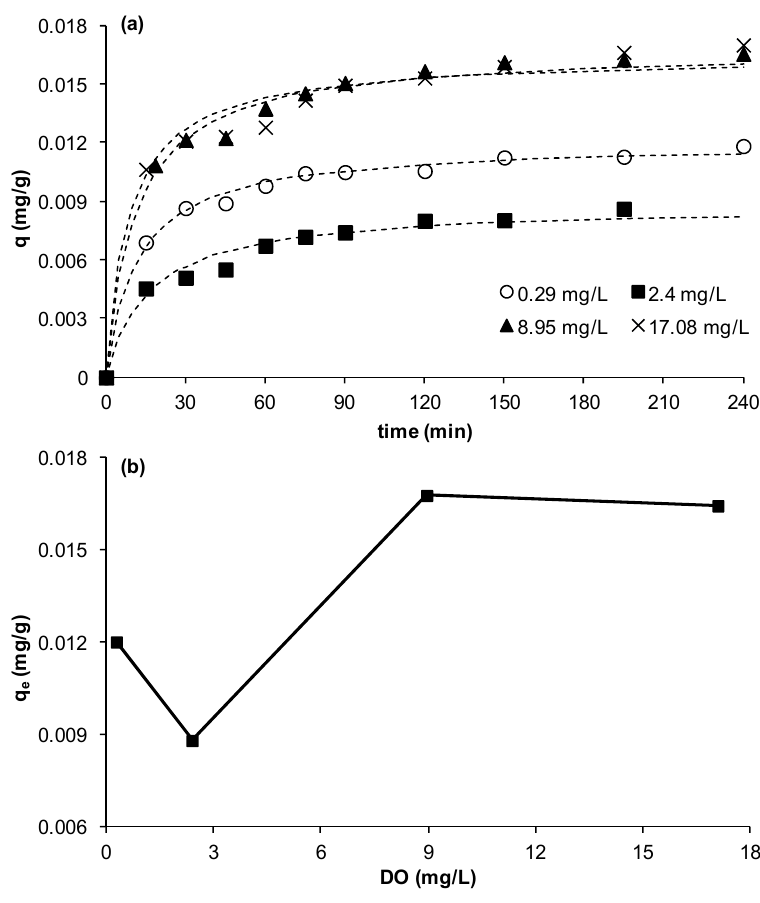
( γ = 0.0709 mg Mn/g sand, m e Mn